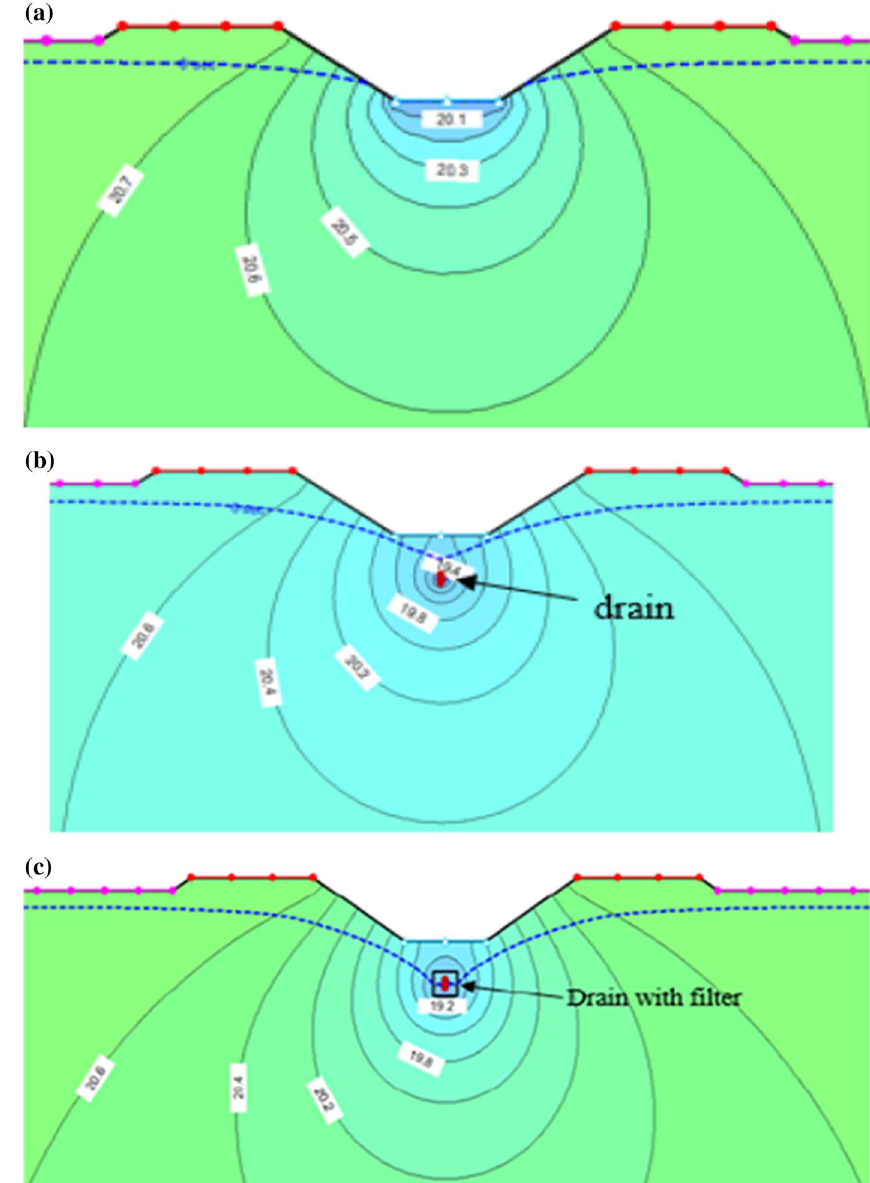
Fig. 16 Potential contour lines in simulated models a without a drain and filter H = 20.8 m, b with a drain, D = 0.2 m, Y = 19 m, H = 20.8 m, c with